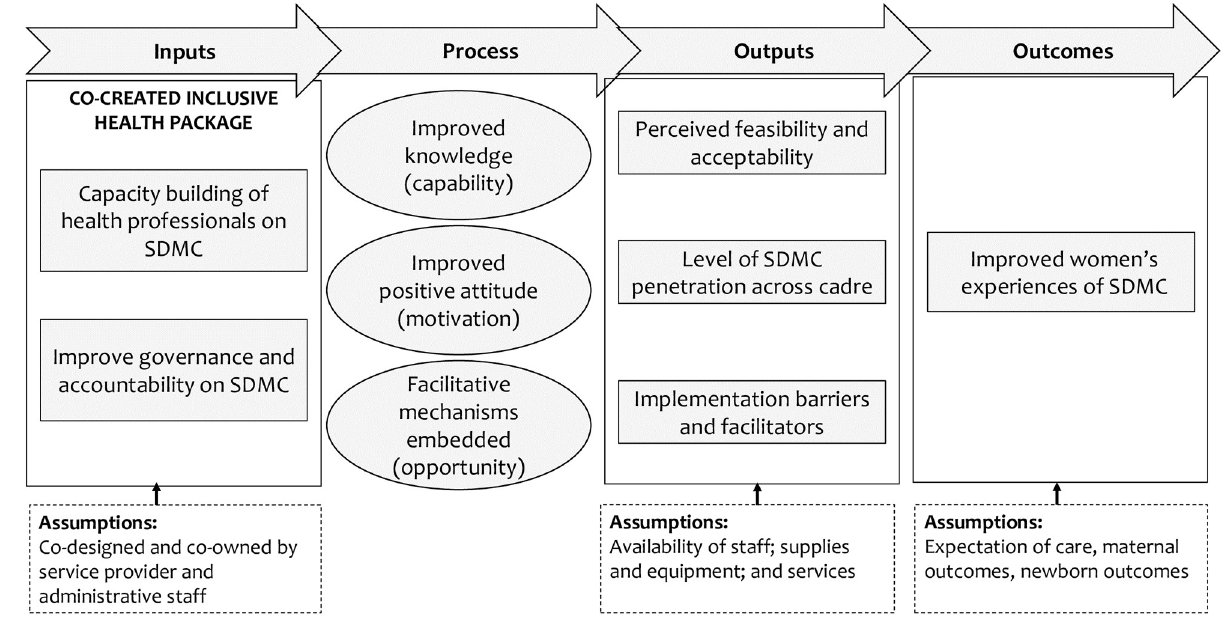
Fig 2. Logic model of the